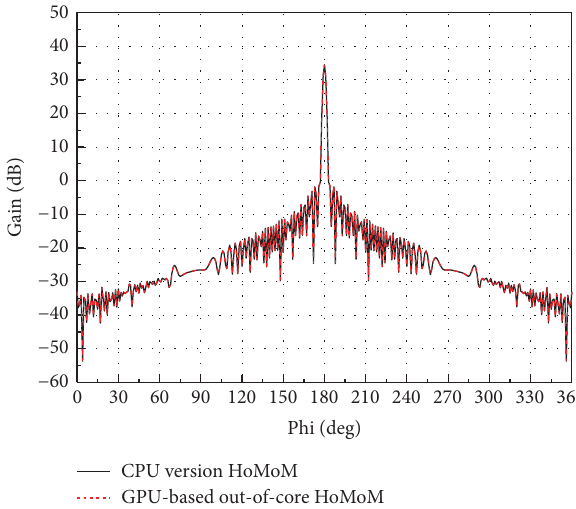
Figure 17: 2D results of the wire array in xoy plane.